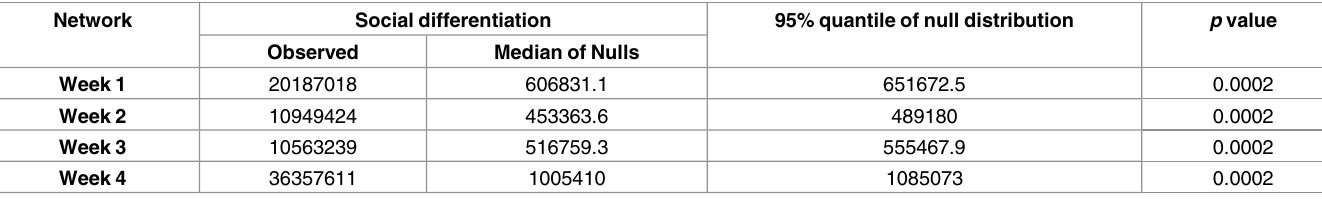
There was significant social differentiation for each week—long social network; calves spent more or less time associating with other individualsthan would be expected by